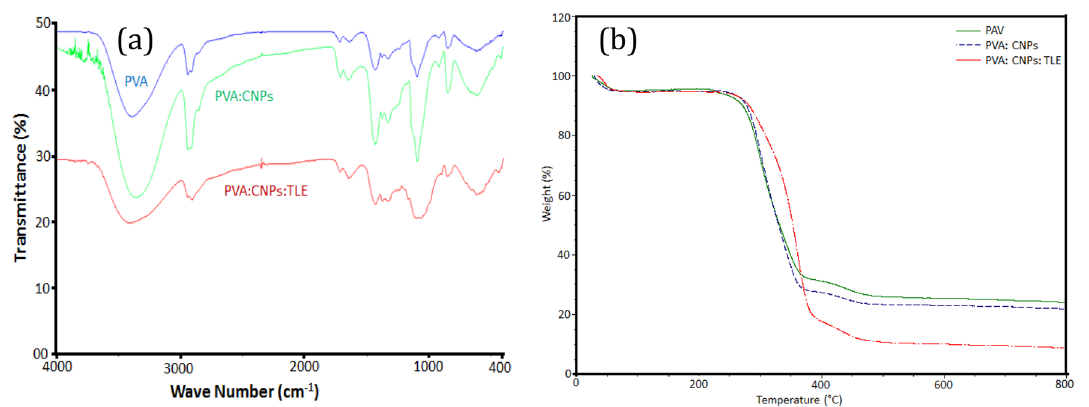
Figure 3. ( a ) FTIR spectra of PVA, PVA: CNPs and PVA: CNPs: TLE and ( b ) TGA spectra of PVA, PVA: CNPs and PVA: CNPs: